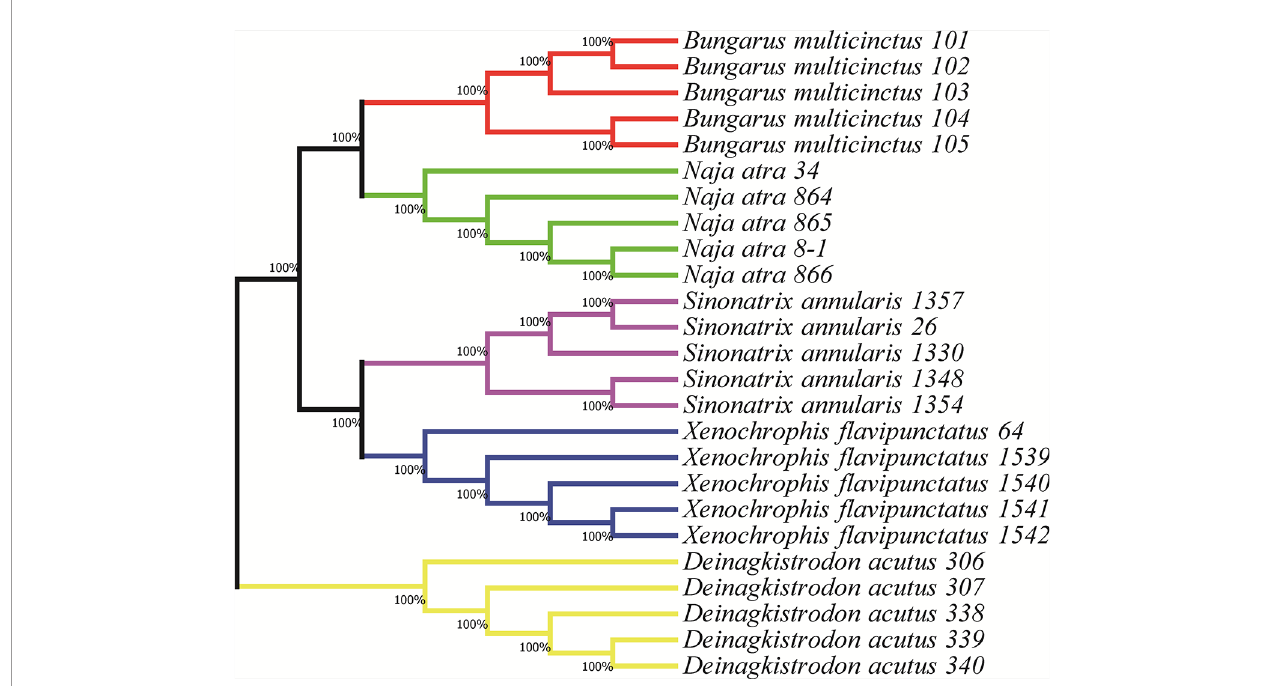
FIGURE 1 | Phylogenetic tree constructed using neighbor joining (NJ), based on the sequences ampli fi ed by universal primers from fi ve species.